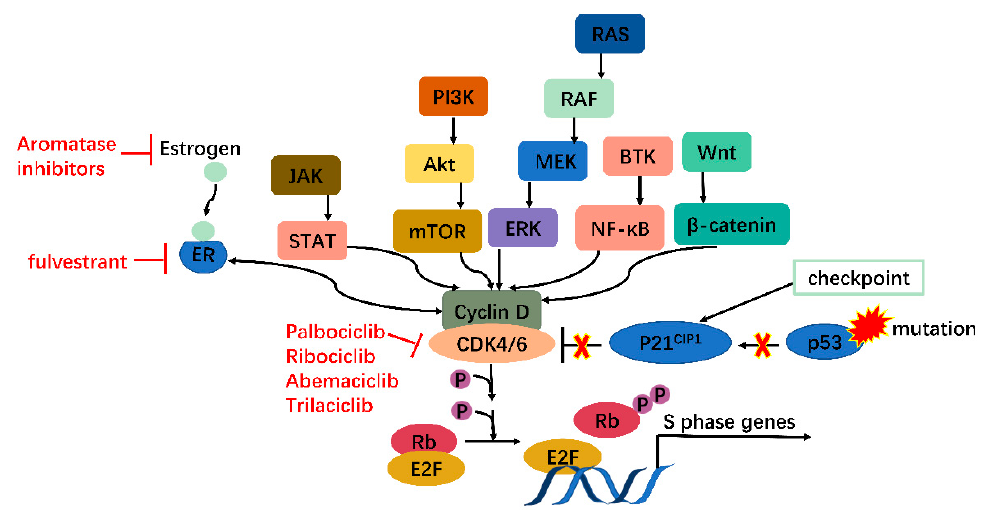
Figure 2. CDK4/6 serves as a hub in tumorigenesis. In cancer, multiple oncogenes may be activated, including those on JAK/STAT, PI3K/Akt/mTOR, RAS/RAF/MEK/ERK, BTK/NF- κ B, Wnt/ β -catenin pathways, etc., all of which meet at CDK4/6-cyclin D complex. Moreover, mutations on tumor suppressor genes such as p53 can enhance CDK4/6 activity via releasing P21 CIP1 inhibition. CDK4/6, therefore, serves as a hub in